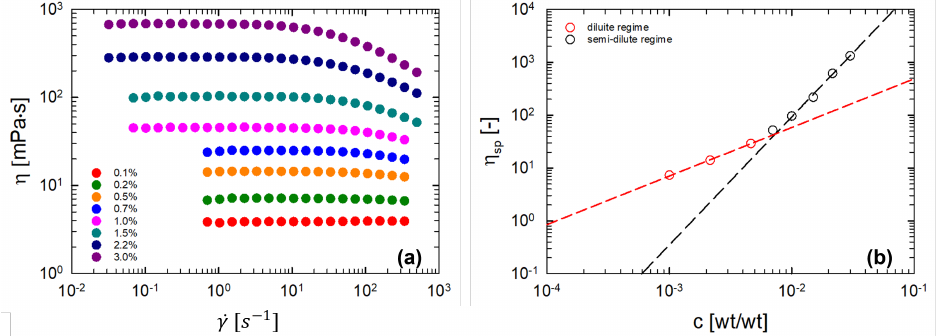
Figure 1. ( a ) Steady viscosity, η , as a function of shear rate, ˙ γ , parametric in the κ -c concentration, at 60 ◦ C. ( b ) Specific viscosities, η sp , at 60 ◦ C ( η water ,60 ◦ C = 5 × 10 − 4 Pa · s) as a function of the κ -c con- centration in solution. Power-law regressions are reported with dashed lines (red line, slope ≈ 0.92; black line, slope ≈